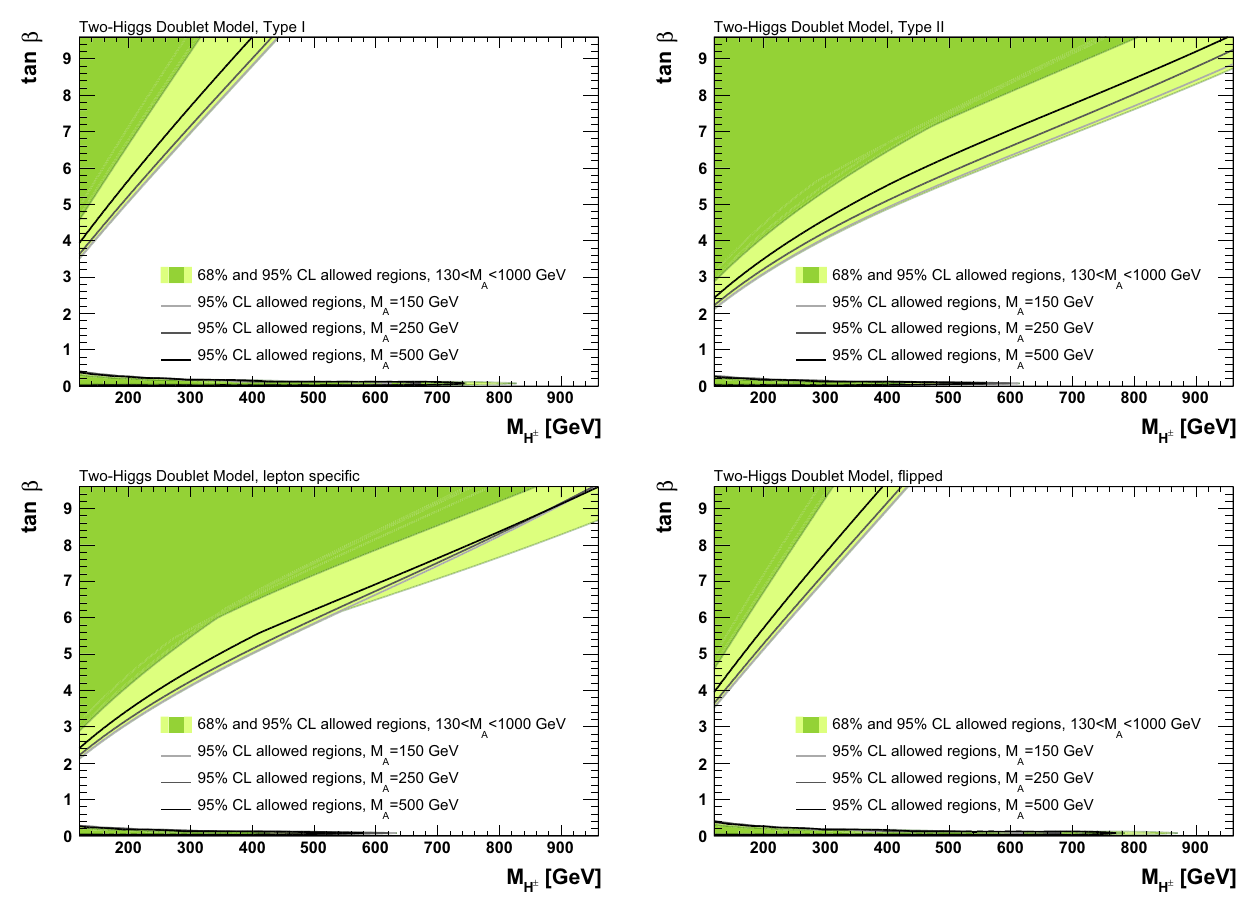
narios considered: Type-I (top left), Type-II (top right), lepton specific (bottom left), and flipped (bottom right). The solid lines indicate 95% CL limits for different fixed values of M